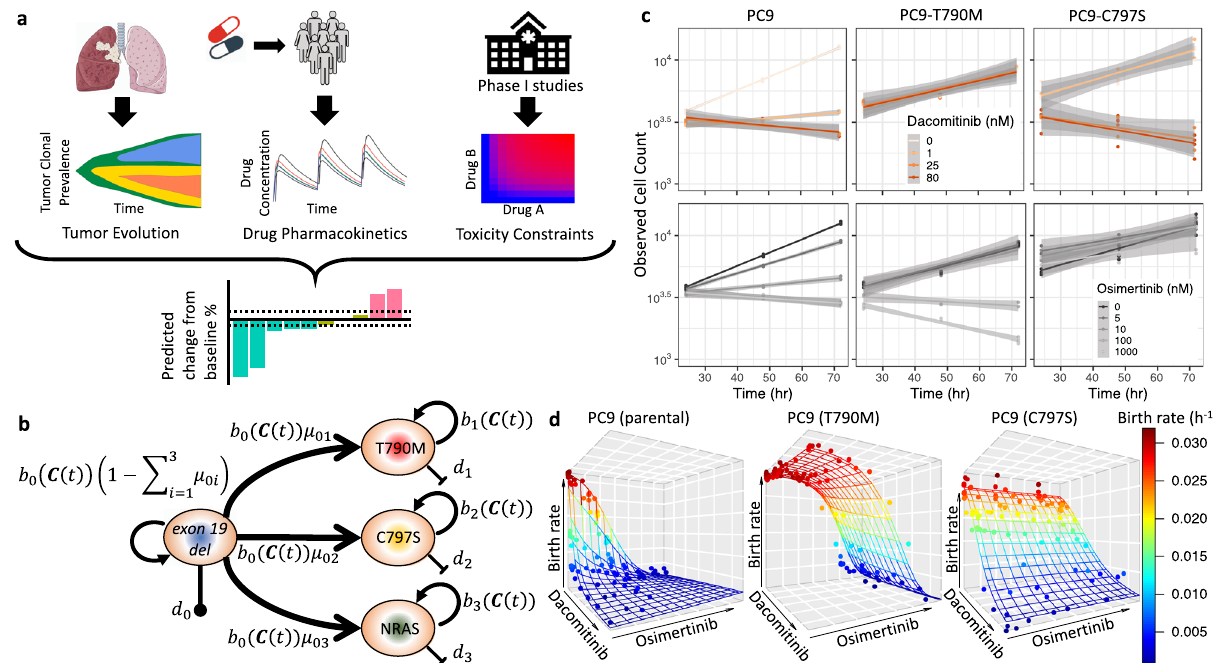
Fig. 1 Overview of the computational modeling framework and its parameterization. a The model ensemble consists of a tumor evolution model of multiple cell types, population drug pharmacokinetic model, and toxicity constraints and can be used to identify the most favorable therapy schedules for osimertinib and dacomitinib combination treatment. The waterfall plot represents predicted patient responses for a given dosing regimen. b The tumor evolution model. Each resistance mechanism arises in a one-step process. Each cell type, i , has its own drug-dependent birth rate and constant death rate, b C ð t ÞÞ and d C t Þ , and osimertinib, C t Þ , were modeled as a function of time t . The vector of two i ð i , respectively. The drug concentrations of dacomitinib, D ð O ð t ð Þ ; C drug concentrations, C t ð Þ ¼ ½ C ð t Þ(cid:2) , served as the input for the multivariate birth function, b i . Under a particular drug-dosing schedule, the rates are D O therefore time-dependent. A mutation from the sensitive cell type to type i occurs at rate μ per cell division. c Total cell counts from CellTiter Glow (CTG) 0 i experiments during osimertinib (gray-scale lines) and dacomitinib treatment (red-scale lines). The slope of each line provides the estimated growth rate for a given cell type and drug concentration. Source data are provided as a Source Data fi le. d Birth rates of cells during combination therapy. Points represent the estimated growth rates from c minus death rates and the contour is the predicted birth rate as a function of dacomitinib and osimertinib